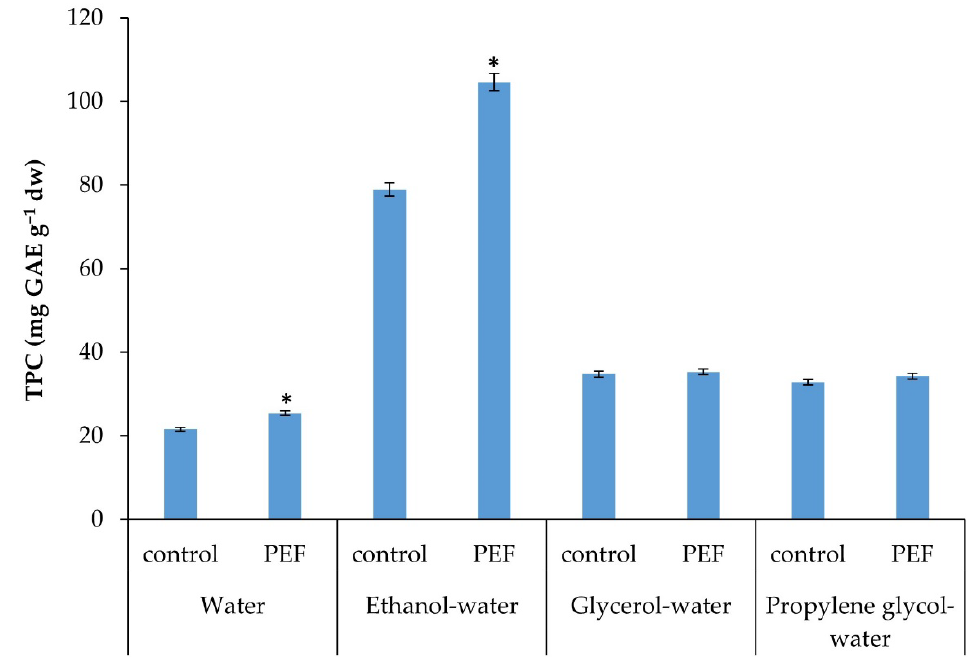
Figure 1. Total polyphenols, TPC (mg GAE g − 1 dw), of the extracts after reaction with the Folin- Ciocalteu reagent; Statistically significant differences are denoted with an asterisk (*) for p < 0.05; Error bars denote the standard deviation of nine replicate analyses.